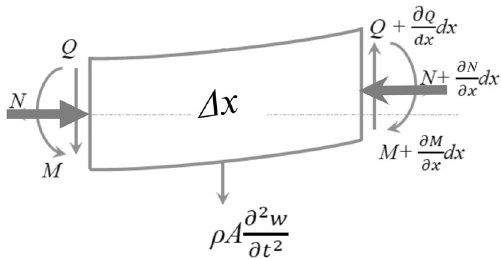
Fig. 4 Infinitesimal section of beam showing forces and moments for a beam displaced from equilibrium